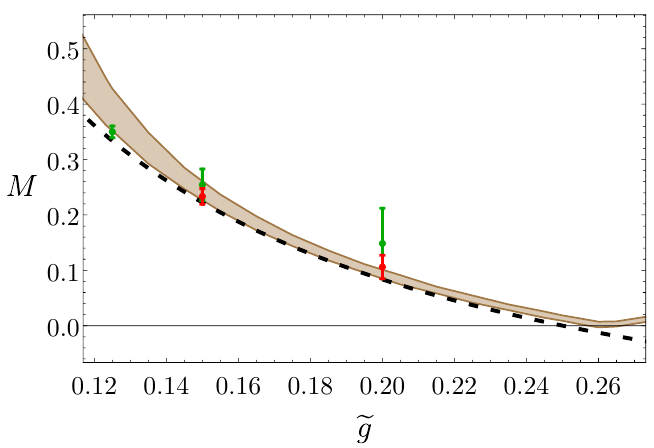
Figure 11 . Comparison between the kink mass and the mass as a function of g in the weakly coupled branch. In brown we have Borel resummation of the perturbative series in the unbroken phase up to order g 8 using conformal mapping. The black dashed line is the kink mass as given by the semiclassical equation (6.1). The e green and red points are the results obtained by ref. [11] from the splitting and antiperiodic sector respectively. See the main text for further